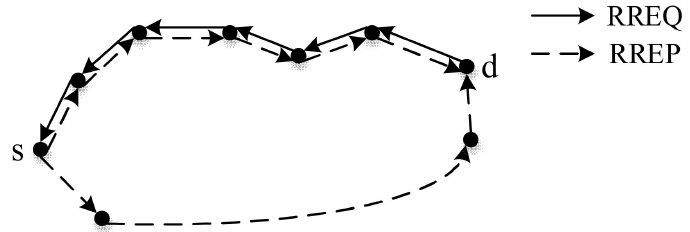
Figure 3. Reactive location